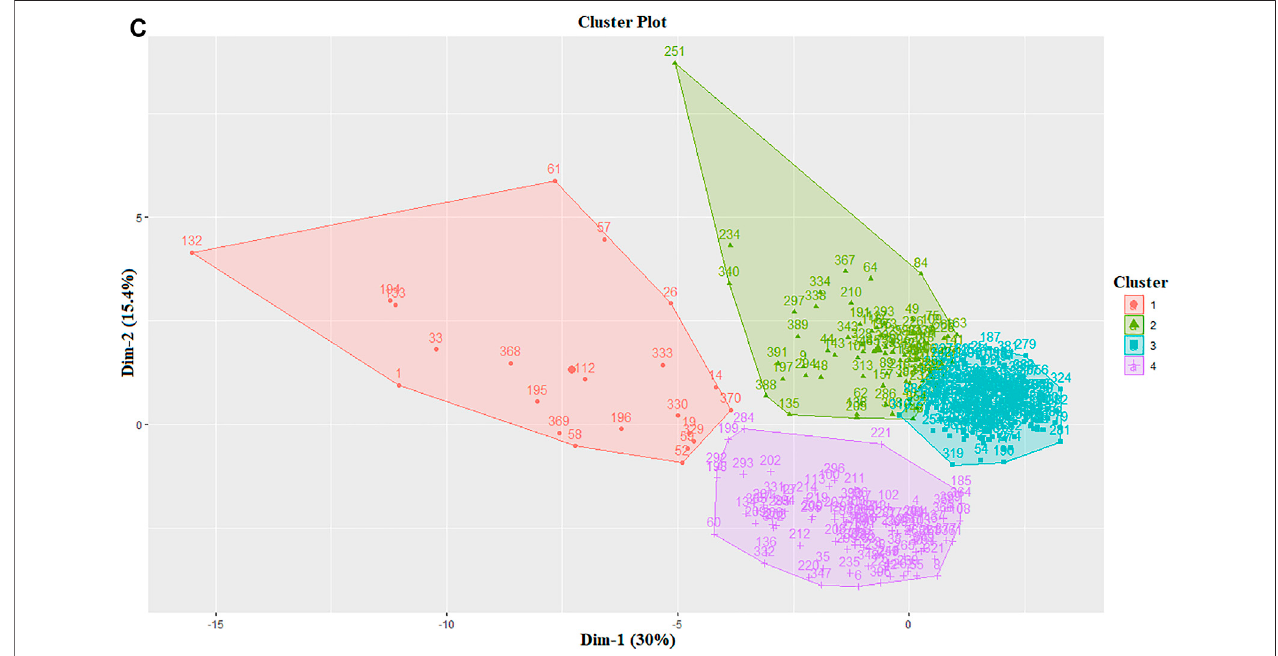
TABLE 3 | One-way analysis of variance of factor scores across four identi fi ed clusters. Principal components